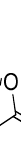
Figure 1. The chemical structure of CLE-10.